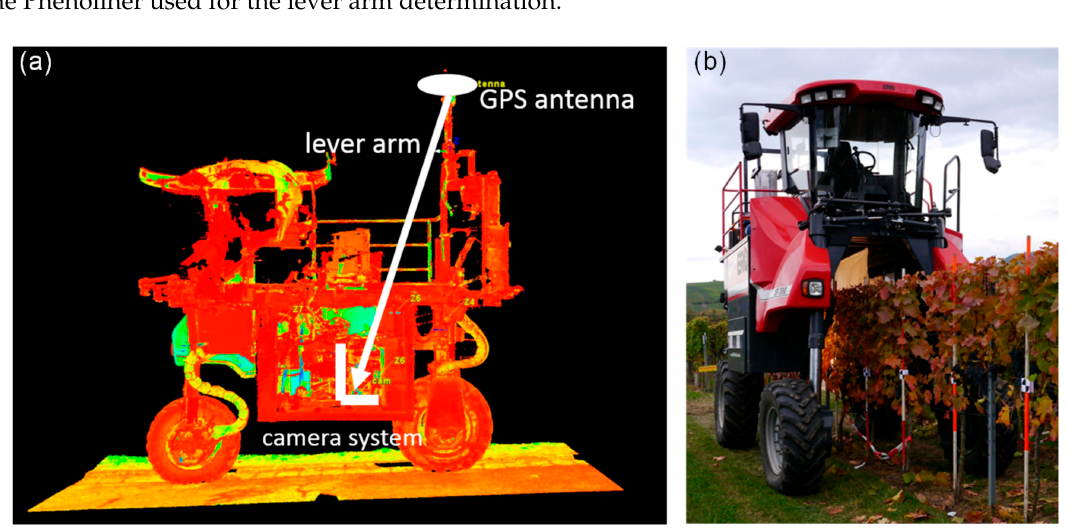
Figure 3. ( a ) Terrestrial laser scan of the Phenoliner to measure the lever arm between the GPS antenna and the camera system. ( b ) Evaluation measurement to test the georeferencing accuracy of the system. The coordinates of the black and white targets at the poles are known and can be compared with the target positions seen in the images.